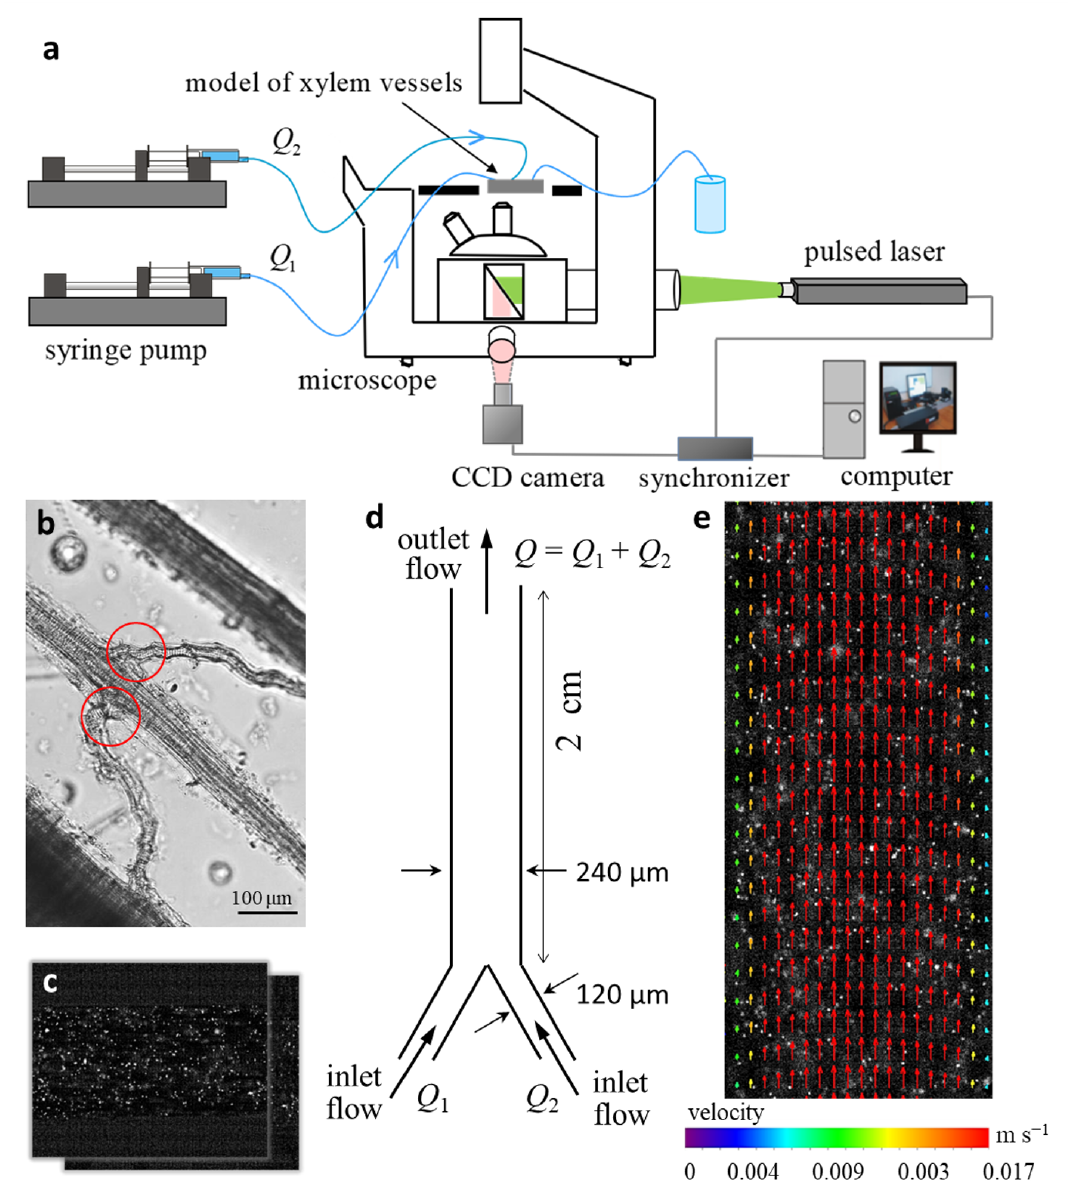
Figure 3. Particle Image Velocimetry. ( a ) General scheme of the experimental stand. ( b ) An example of xylem vessel connections (marked by red circles) corresponding to microchannel prototype “Y-type xylem vascular connection”. The image of xylem vessels in a maize leaf was obtained after 2 h of enzymatic degradation of tissues under bright light on an Olympus BX53 microscope (Olympus corporation, Japan) with 20 × magnification. ( c ) Double image of tracer particles in model microchan- nel. ( d ) Scheme of prototype “Y-type xylem vascular connection”. ( e ) Instantaneous velocity field obtained for the double image superimposed on the tracer particle